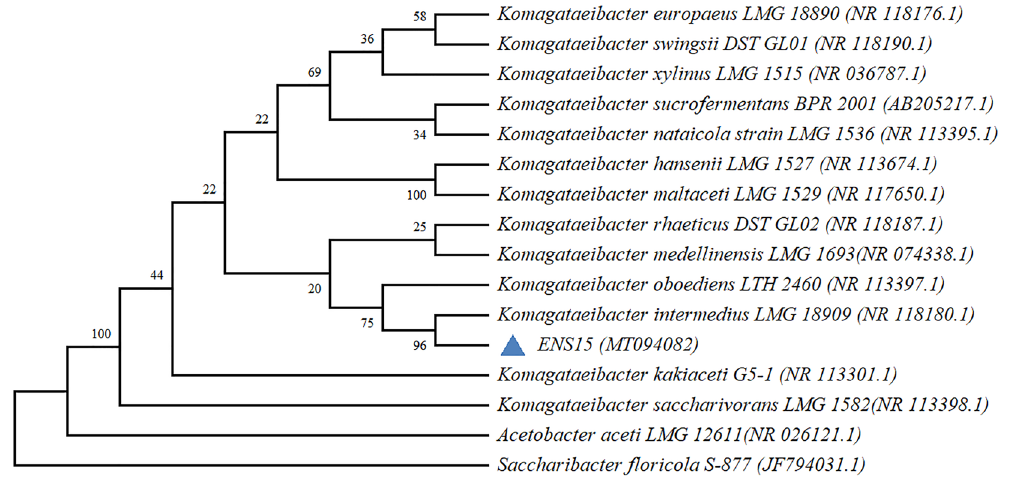
Figure 1. 16S rRNA gene-based phylogenetic relationship of ENS15 and Komagataeibacter type strains (NCBI accession numbers in parenthesis). The tree, drawn using MEGA X integrated tool 14 (https:// www. megas oftwa re. net/, version 10.2.4), was rooted using Saccharibacter floricola JCM 12116. The percentage of replicate trees in which the associated taxa clustered together in the bootstrap test (1000 replicates) are shown next to the